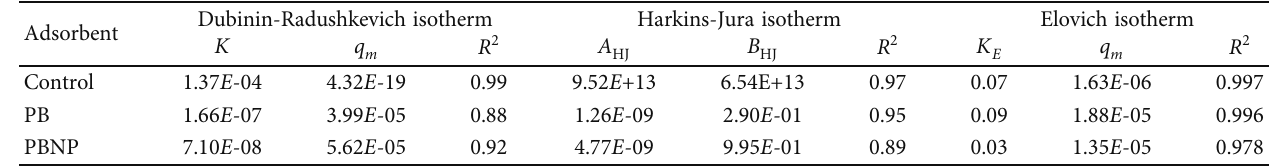
Table 2: Parameters obtained from the isotherm models on MB dye unto the